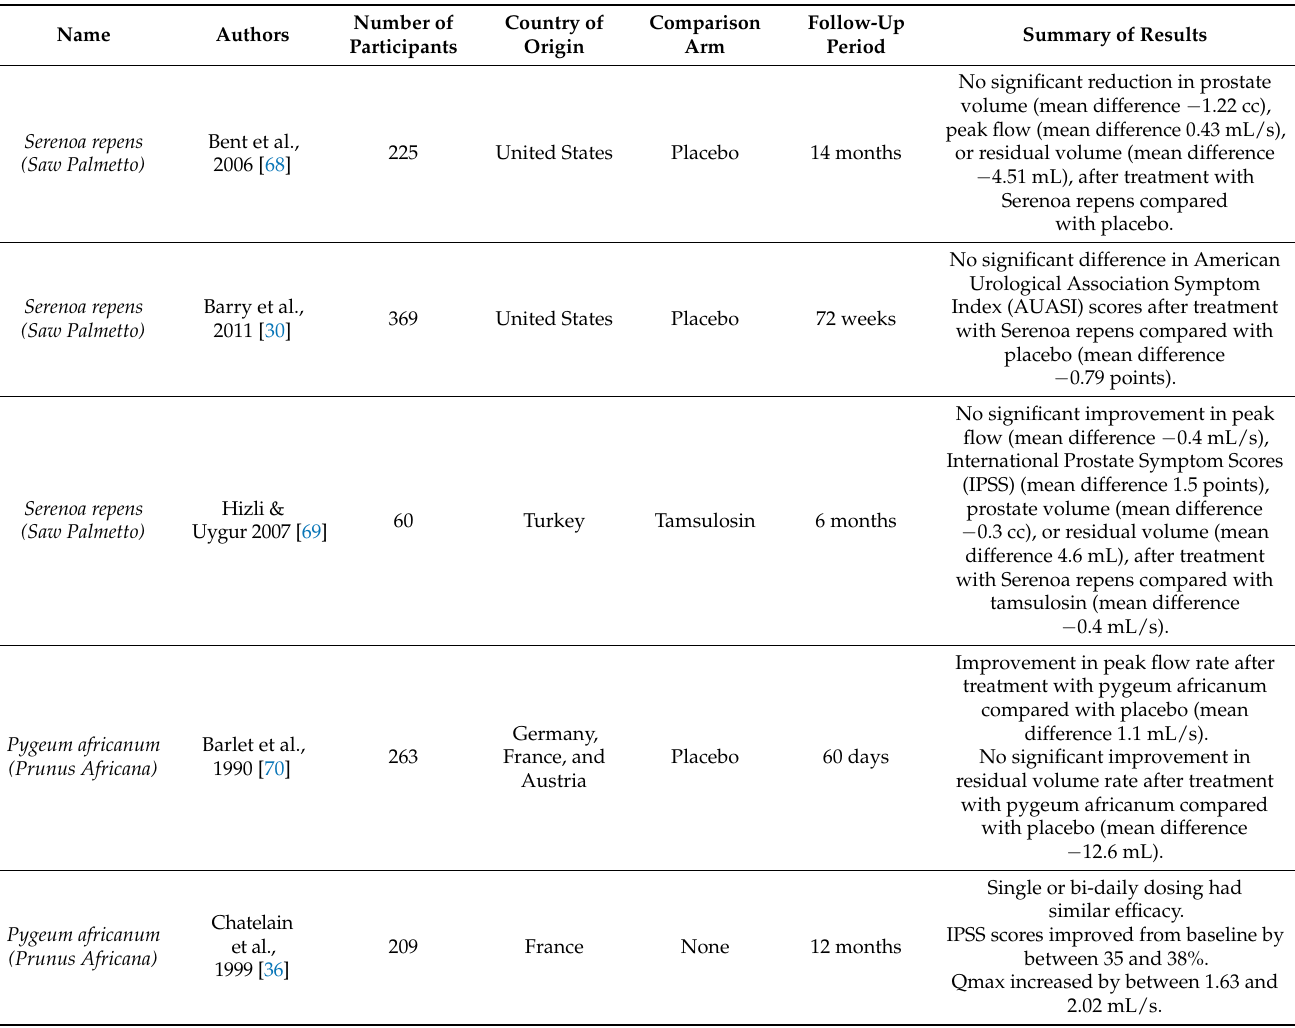
Table 2. Summary of relevant literature examining the role of phytotherapies in treating LUTS attributable to